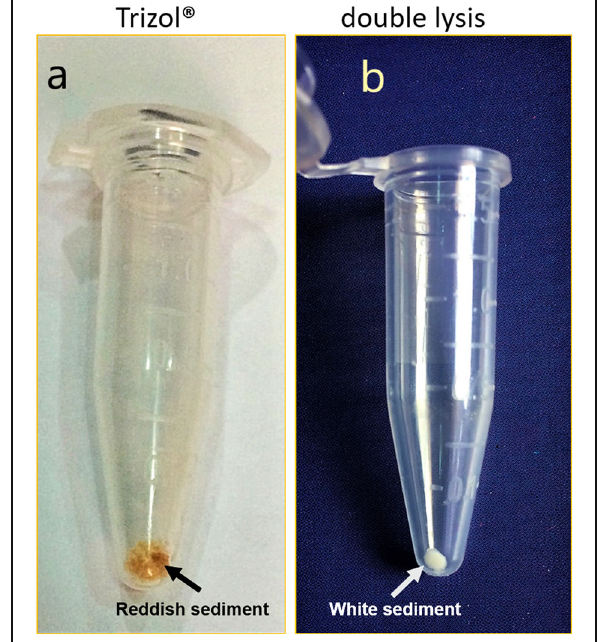
Fig. 1 Variation in the appearance of RNA sediments isolated from strawberry leaves, a by standard Trizol-based extraction and b as compared to the double-lysis